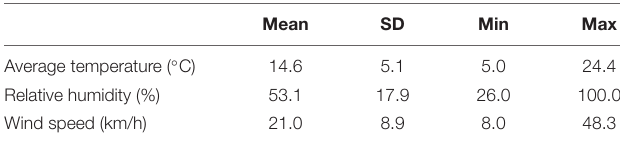
TABLE 1 | Weather conditions in the “New York City Marathon” on race